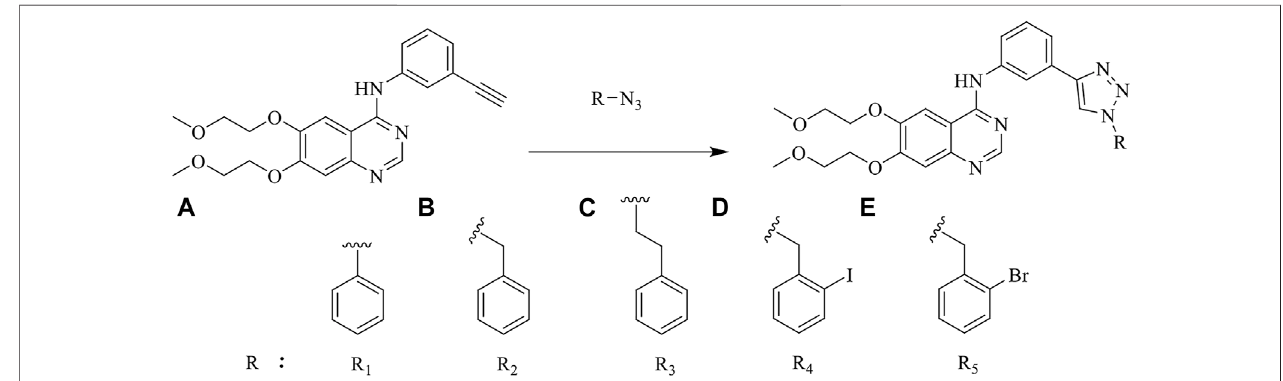
FIGURE 5 | The reaction routes to erlotinib-1,2,3-triazole derivatives.